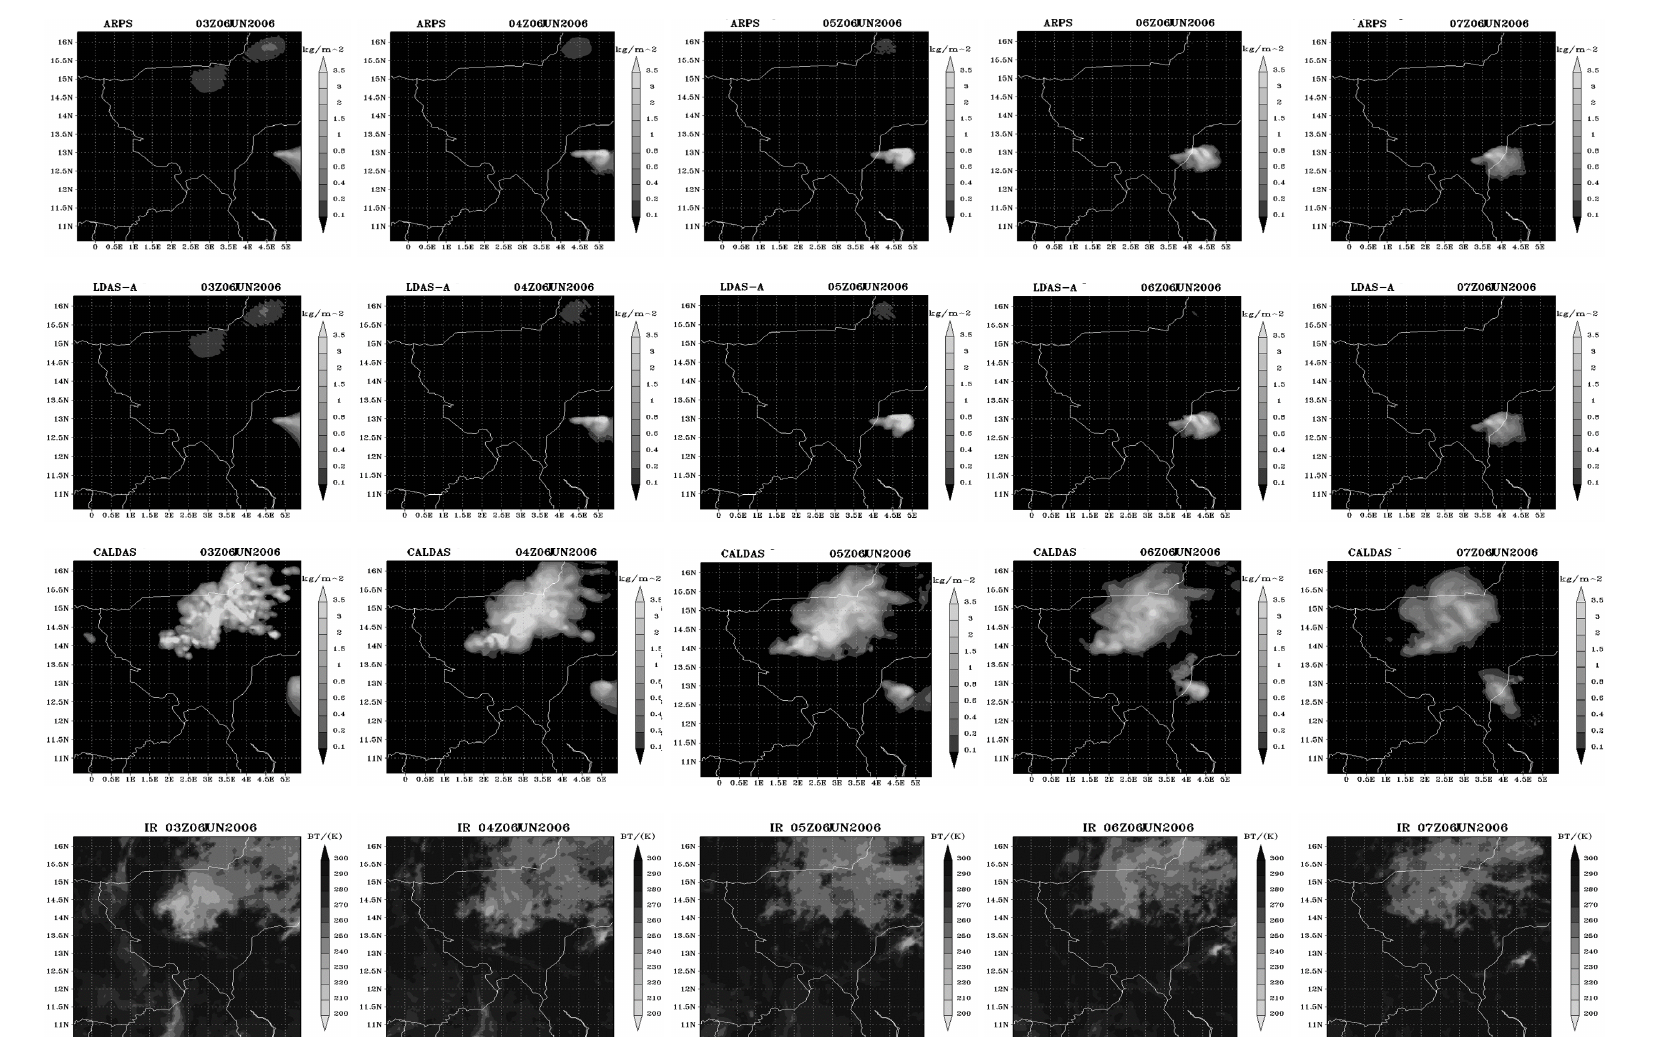
Figure 4. Hourly variation of integrated condensate (kg/m 2 ) and IR data (K); first row: ARPS, second row: Land Data Assimilation System coupled with Atmospheric model (LDAS-A), third row: CALDAS, and fourth row: infrared (IR) brightness